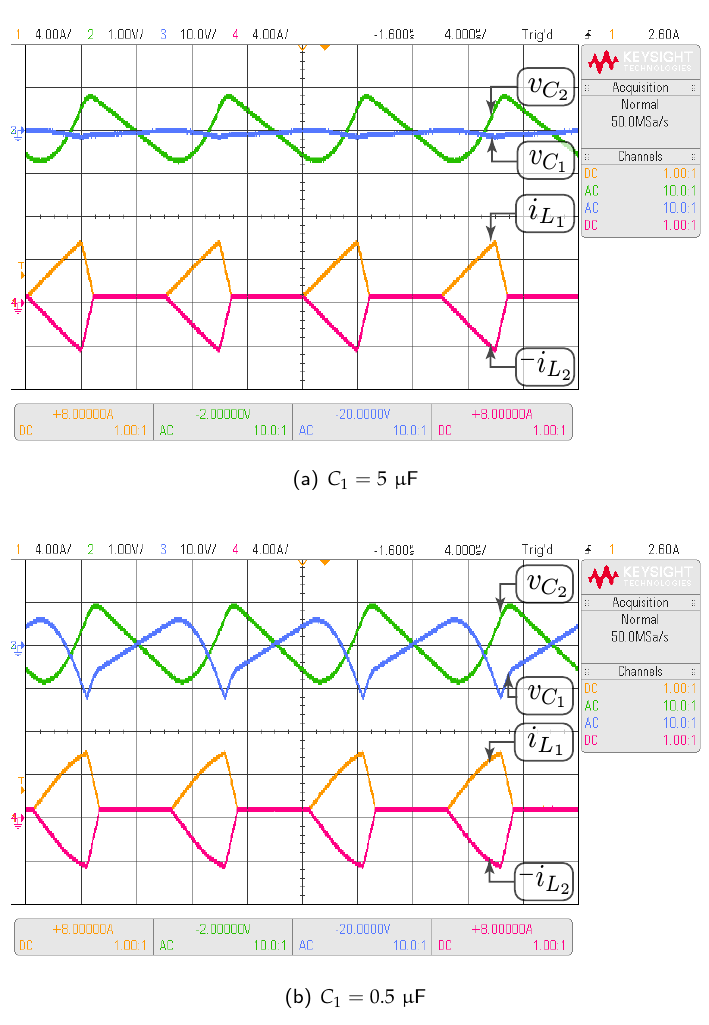
Figure 12. HIL test to validate the proposed model and the simulation of the switched model using PSIM by the Zeta converter with negative magnetic coupling shown in Figure 8: ( a ) C 1 = 5 µ F, ( b ) C 1 = 0.5 µ F. CH1: i l (4 A/div), CH2: v C (1 V/div, ac coupling), CH3: v C 2 1 CH4: − i l (4 A/div), and time base of 4 2